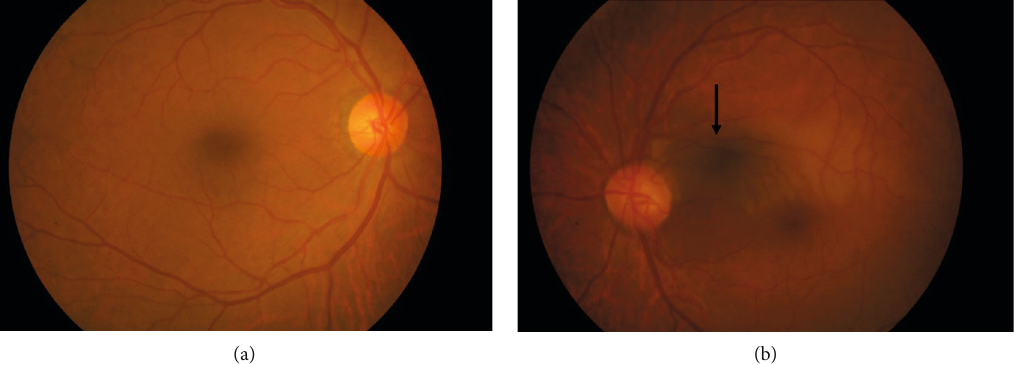
Figure 1: Color fundus photographs of the (a) right eye and (b) left eye. (a) In the right eye, no obvious fundus abnormalities are apparent. (b) In the left eye, the cilioretinal artery extends from the upper temporal side of the optic nerve papillae to the temporal side. White change is seen in the retina along the cilioretinal artery.